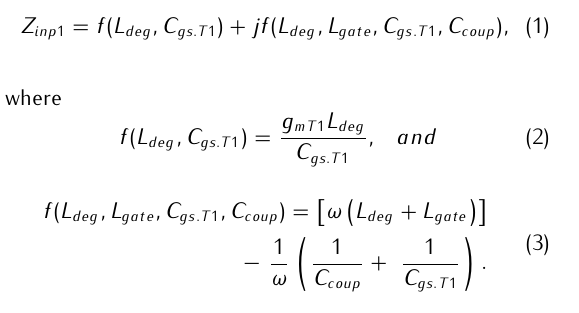
Figure 2. a) The load impedance network formed by the resonance tank; b) an equivalent model showing the effect of